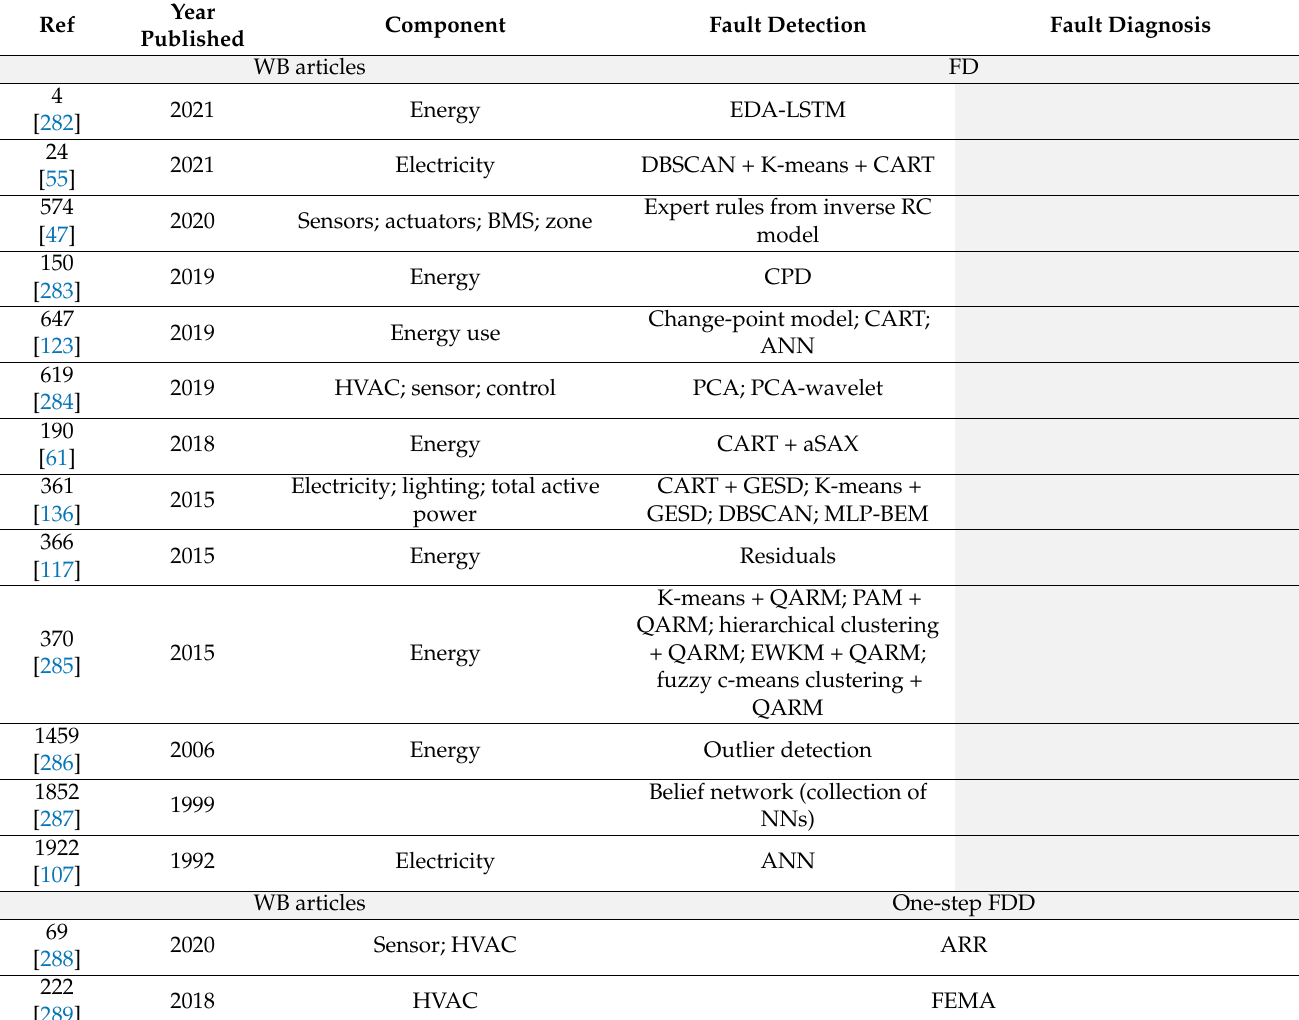
Table A6. Energy use: Whole